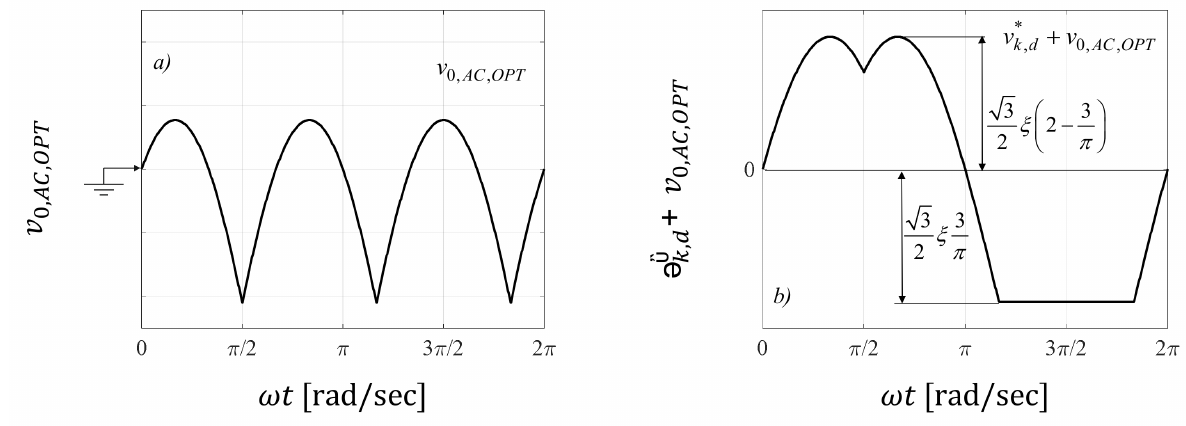
Figure 4. Qualitative waveform of the generic arm reference voltage in the presence of the proposed AC common mode injection: ( a ) AC proposed common mode components, and ( b ) total AC arm reference